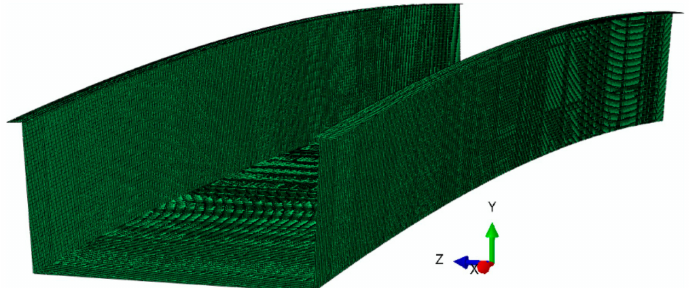
Figure 3. Visualization of the footbridge numerical